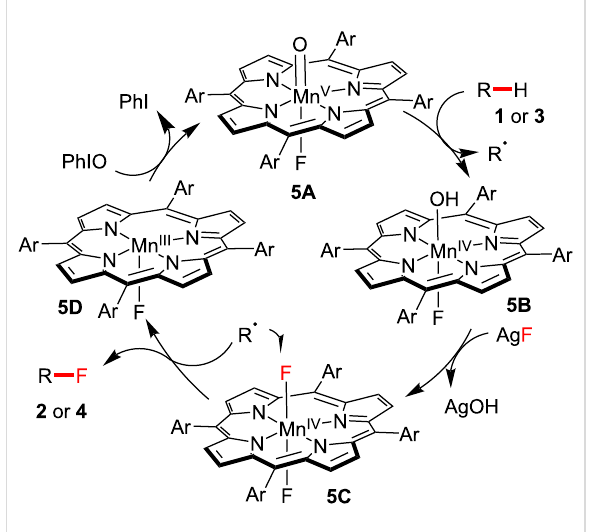
Figure 1: Proposed reaction mechanism of C–H fluorination by a manganese porphyrin